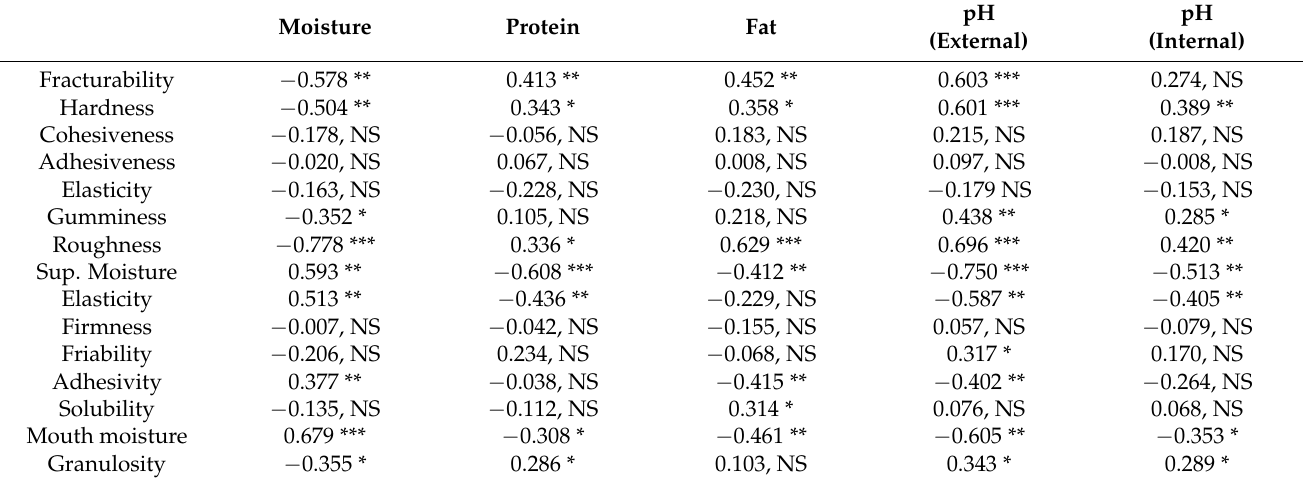
Table 3. Correlation analysis of sensorial and instrumental texture characteristics with physicochemical